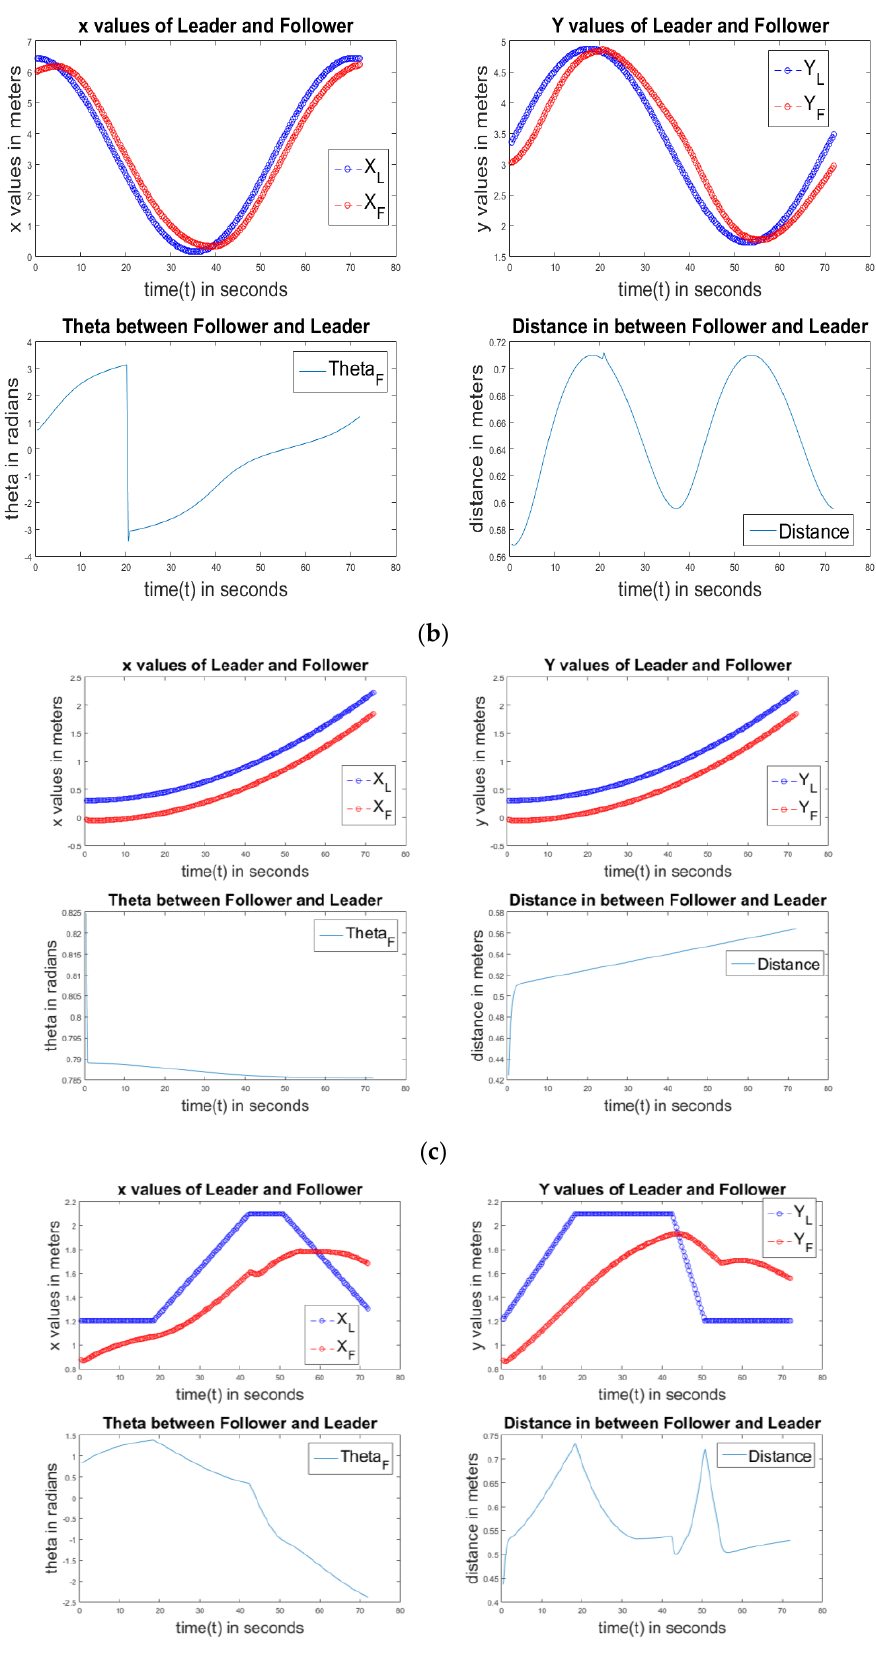
Figure 11. ( a ) PD controller of a circle; ( b ) PD controller of an ellipse; ( c ) PD controller of a line; ( d ) PD controller of a square.